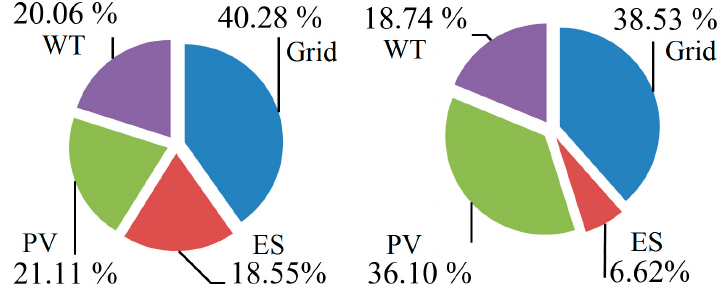
Figure 8. Load sharing between distributed generators and grid after the prosumer problem solution. ES: energy storage.